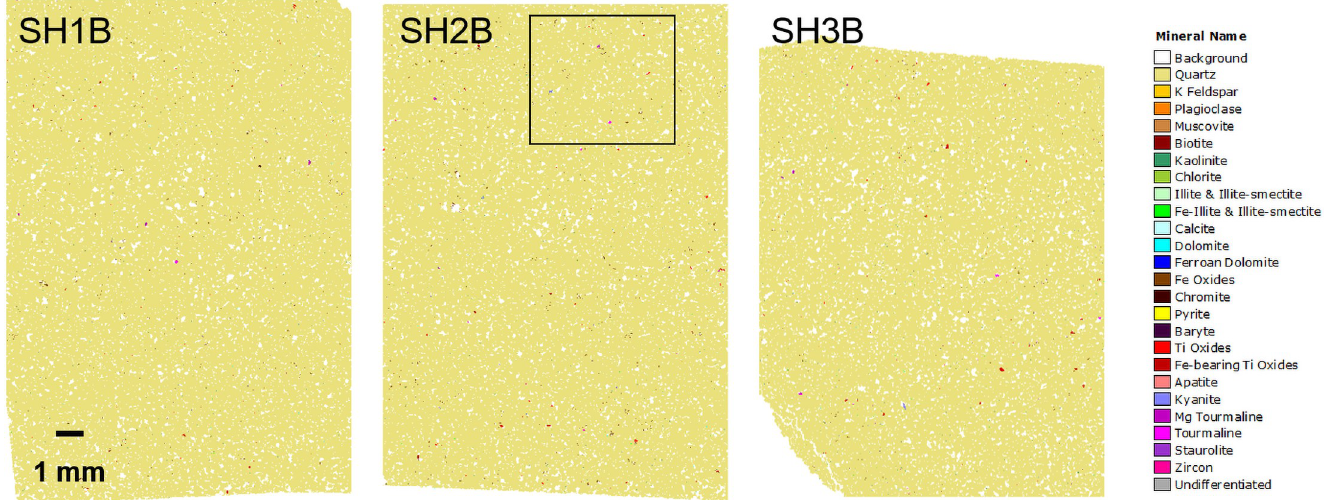
Fig 11. Automated SEM-EDS (QEMSCAN) mineralogical maps for polished thin-sections SH1B, SH2B and SH3B from section 2–3 of the Phillips’ Core. The box indicates the location of the higher resolution mineralogical map shown in Fig 12.